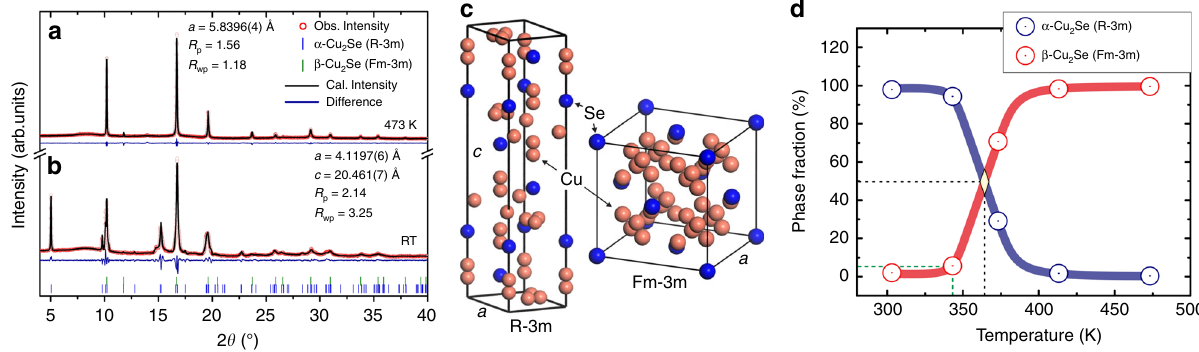
Fig. 1 Structure analysis on Cu 2 Se. a Synchrotron radiation powder diffraction patterns at room temperature (RT) and b 473 K together with Rietveld analysis data including space groups R -factors and lattice constants. c High/low-temperature crystal structure of Cu 2 Se. d Phase fractions of α -Cu 2 Se and β -Cu 2 Se as obtained from